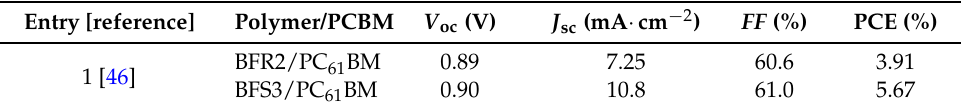
Table 1. Characteristic properties of polymer solar cells.